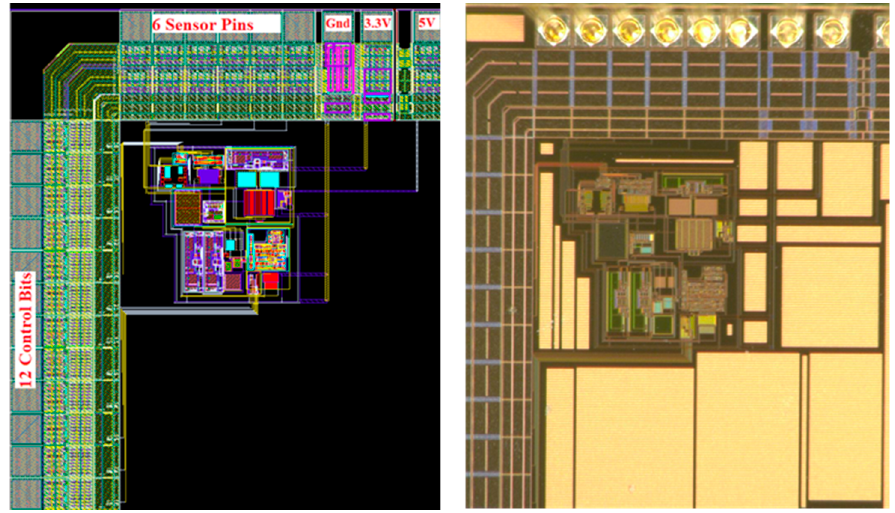
Figure 12. First demonstration IC for post-fabrication electrical trimming of resistive sensors: layout view ( left ) and photograph ( right ).